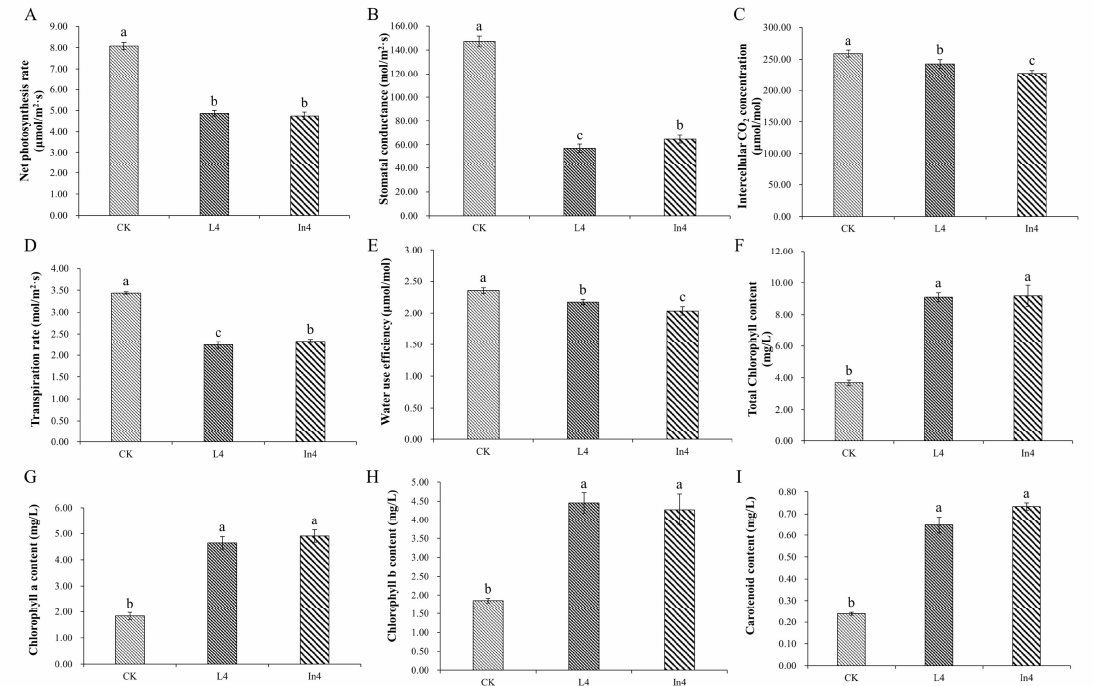
Figure 3. Changes in photosynthetic indicators and pigments in P. koraiensis under different supple- mentary lights. ( A ) Net photosynthetic rate (Pn). ( B ) Stomatal conductance (Gs). ( C ) Intercellular CO 2 concentration (Ci). ( D ) Transpiration rate (Tr). ( E ) Water use efficiency (WUE). ( F ) Total chlorophyll content. ( G ) Chlorophyll a content. ( H ) Chlorophyll b content. ( I ) Carotenoid content. CK: Control. L4: Supplementary LED for 4 h. In4: Supplementary incandescent lamp for 4 h. The error bars represent the standard error. Different letters indicate significant differences among different treatments.